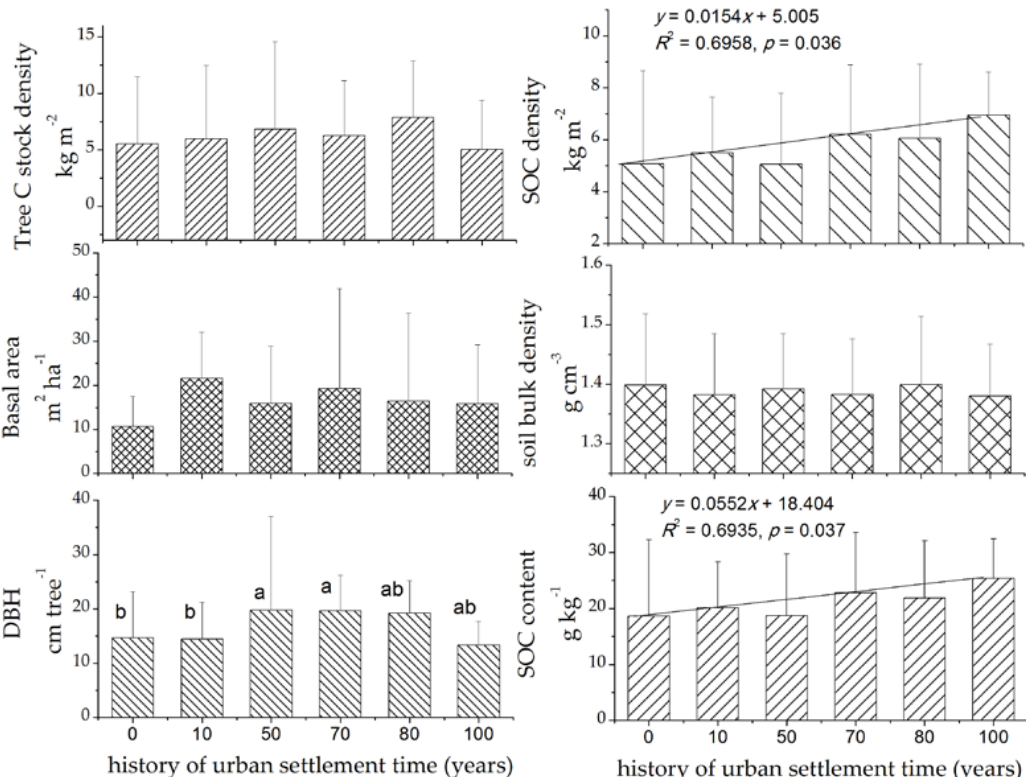
Figure 4. Differences in tree C stock density, basal area, and diameter at breast height (DBH) ( left ), plus differences in soil organic carbon (SOC) density, SOC content, and soil bulk density ( right ) across the history of urban settlement time-based urban-rural gradients in Harbin City. The same letters (e.g., a and a, ab) indicate no significant differences, and different letters (e.g., a and b, or b and c) indicate significant differences ( p < 0.05) based on the one-way ANOVA test statistics.